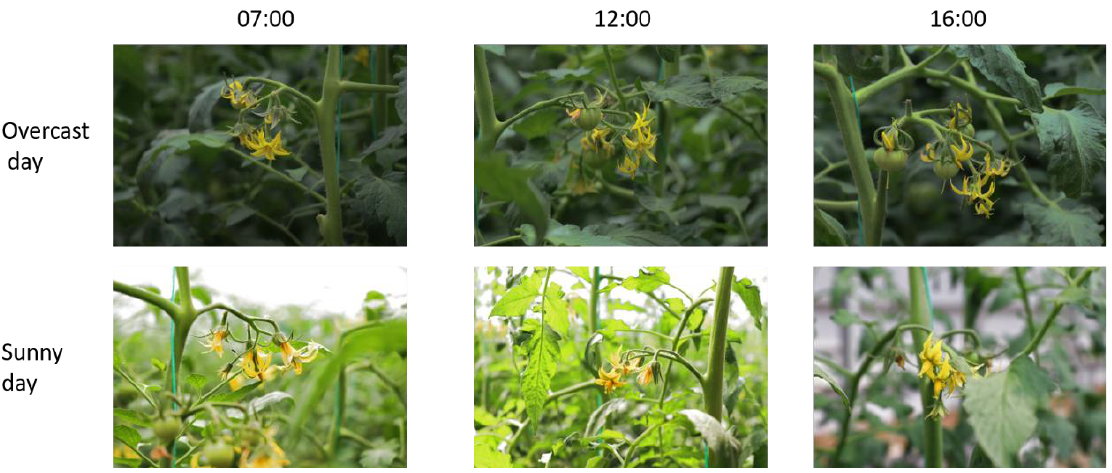
Figure 2. Examples of tomato flowers collected at different times and under different weather con- ditions.